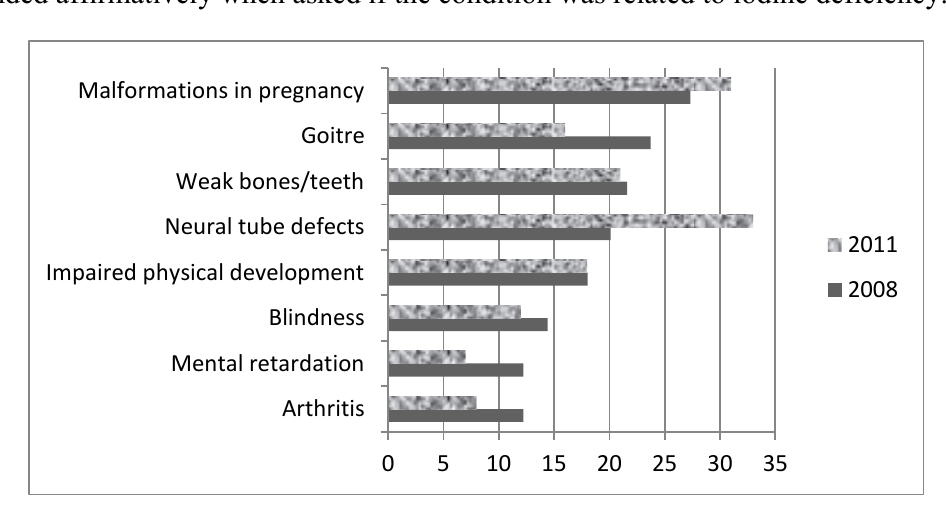
Figure 1. Knowledge of adverse consequences associated with iodine deficiency: Pre- (2008; N = 139) and Post- (2011; N = 147) fortification: % pregnant subjects who responded affirmatively when asked if the condition was related to iodine